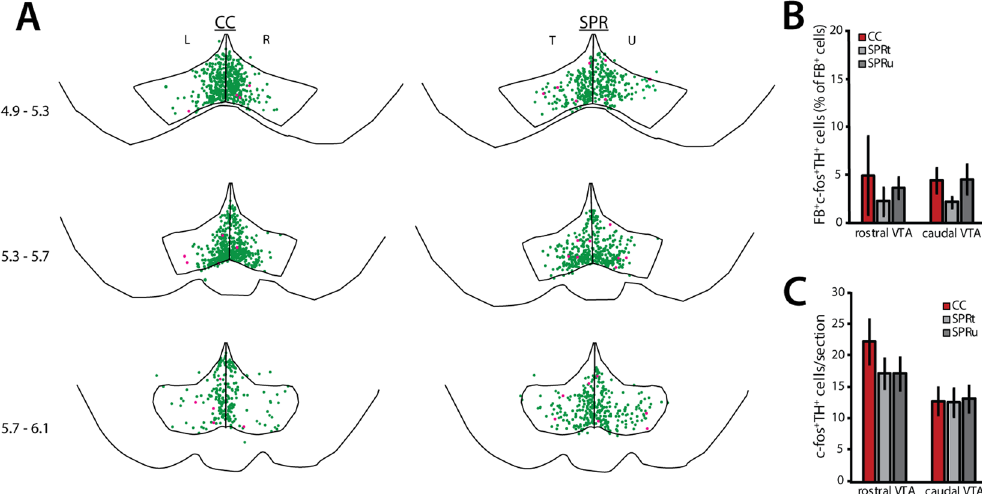
Figure 5. c-fos expression in dopaminergic neurons during unsuccessful acquisition (UA, N = 6 per group). SPR = single pellet reaching, CC = cage control. T = trained, U = untrained, L = left, R = right hemisphere. Values are mean ± s.e.m. ( A ) Superposition of TH + c-fos + (green) and FB + TH + c-fos + (pink) neurons in VTA derived from 6 animals (2 sections per position per animal). Numbers indicate position relative to bregma. ( B ) Number of FB + TH + c-fos + neurons in rostral and caudal VTA sections. ( C ) Number of TH + c-fos + neurons in rostral and caudal VTA